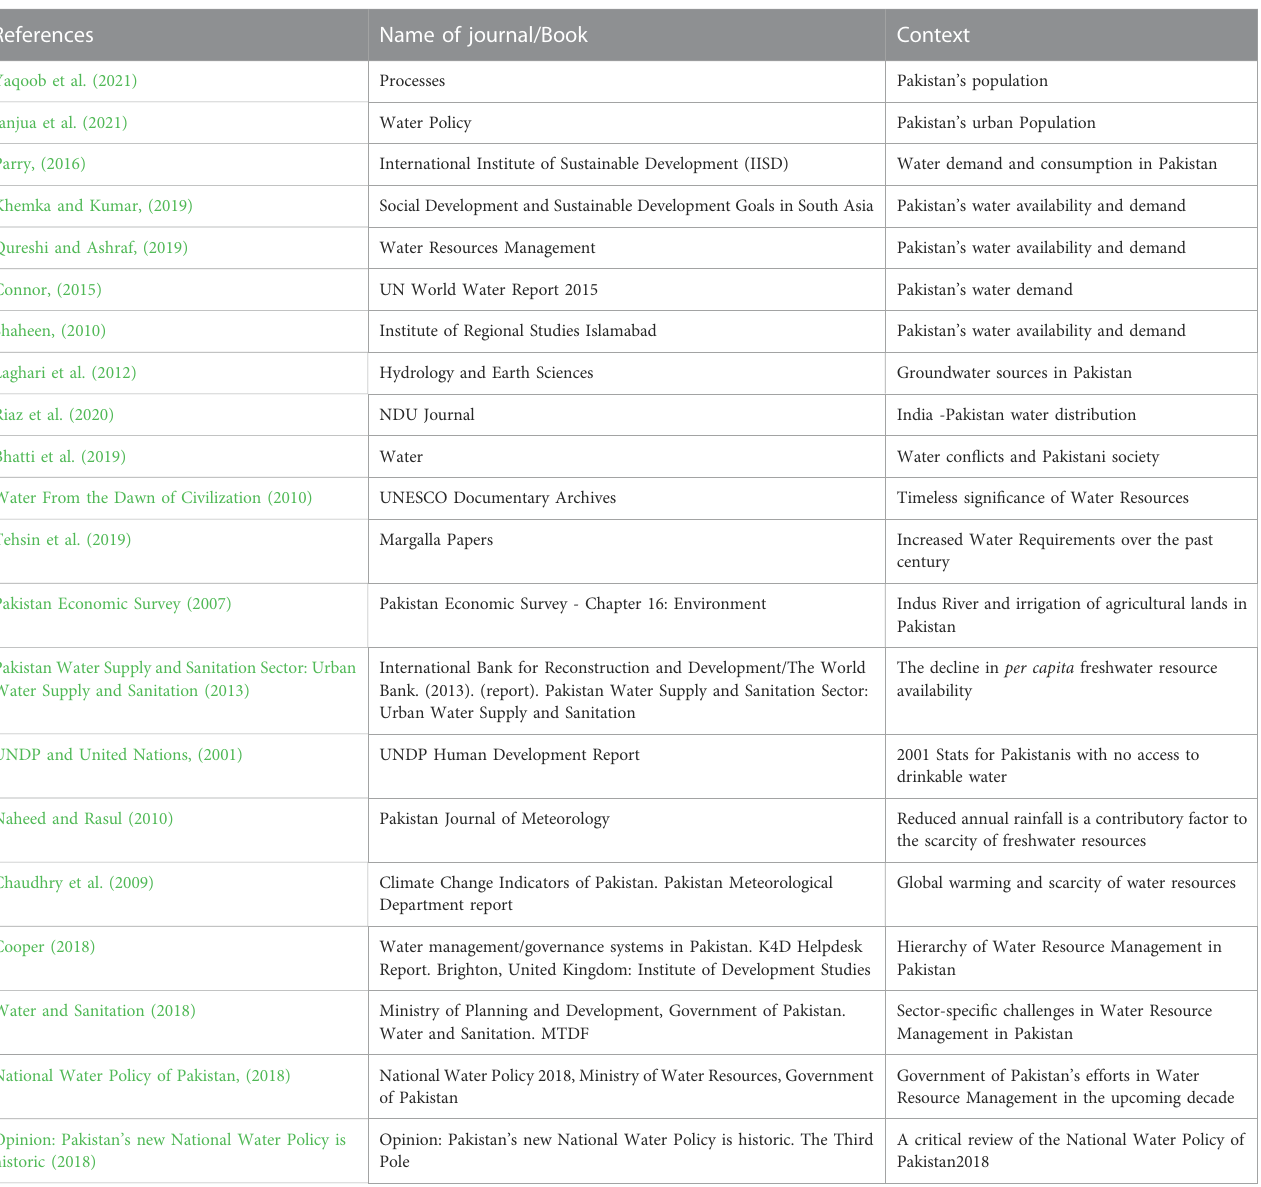
TABLE 1 Summary of literature